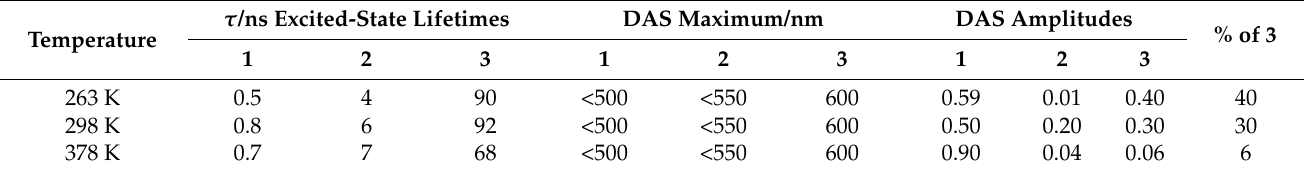
Table 3. Amplitudes and maxima of the decay-associated spectra (DAS) for the lifetime components of ZnO–SiO 2 solid films at different